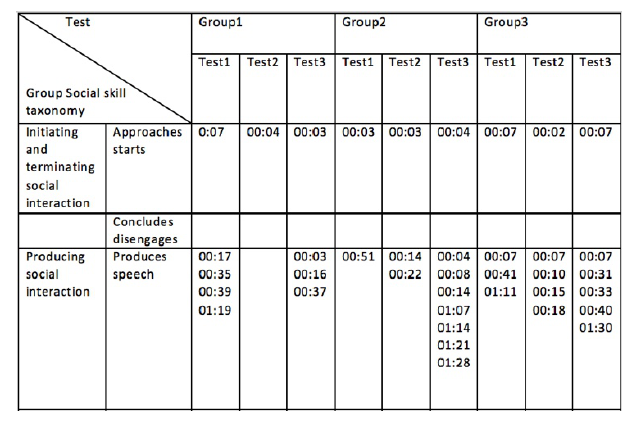
Table 7. Analysis results based on evaluation of